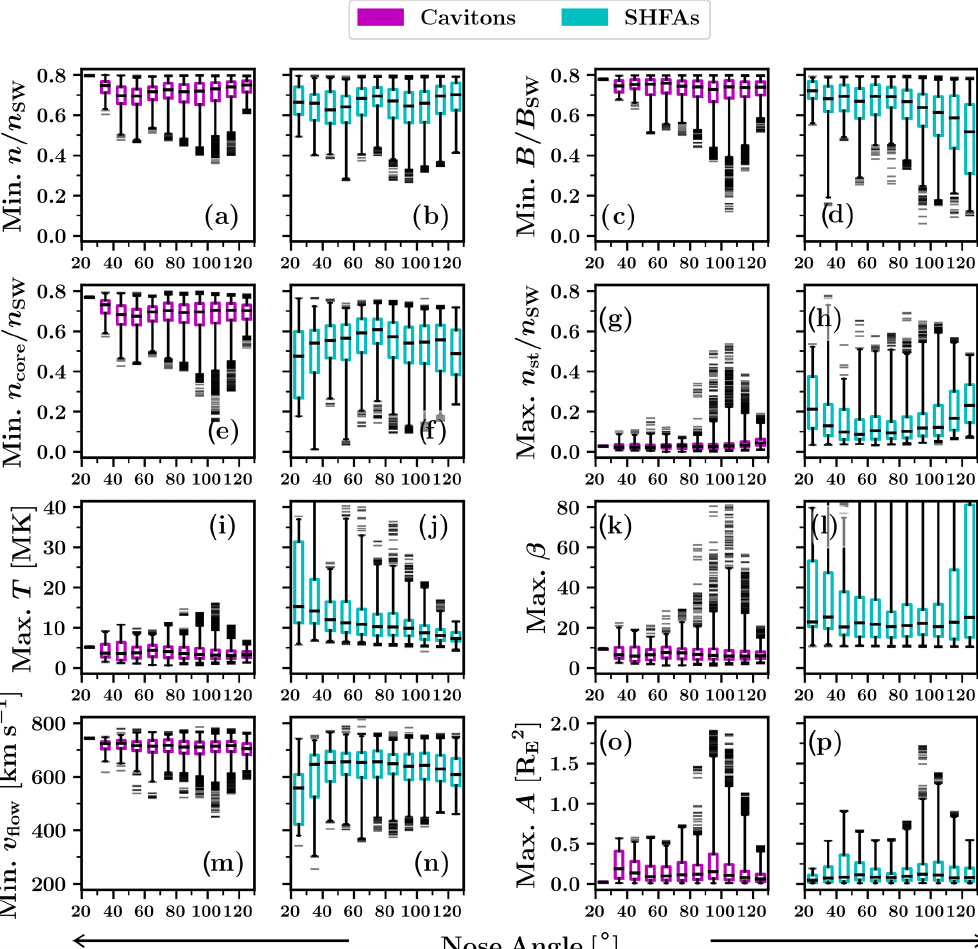
Figure 7. Box-and-whisker plots showing the variation of the tracked transients’ physical properties with the nose angle. Each box covers an angle of 10 ◦ . See Fig. 6 for a detailed explanation of the box-and-whiskers